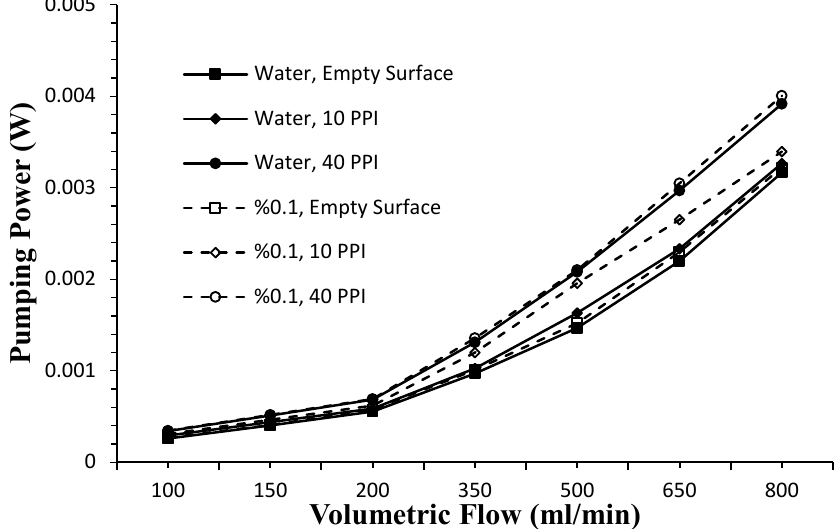
Figure 12. Pumping power for nanofluid and water for different volumetric flow rates.